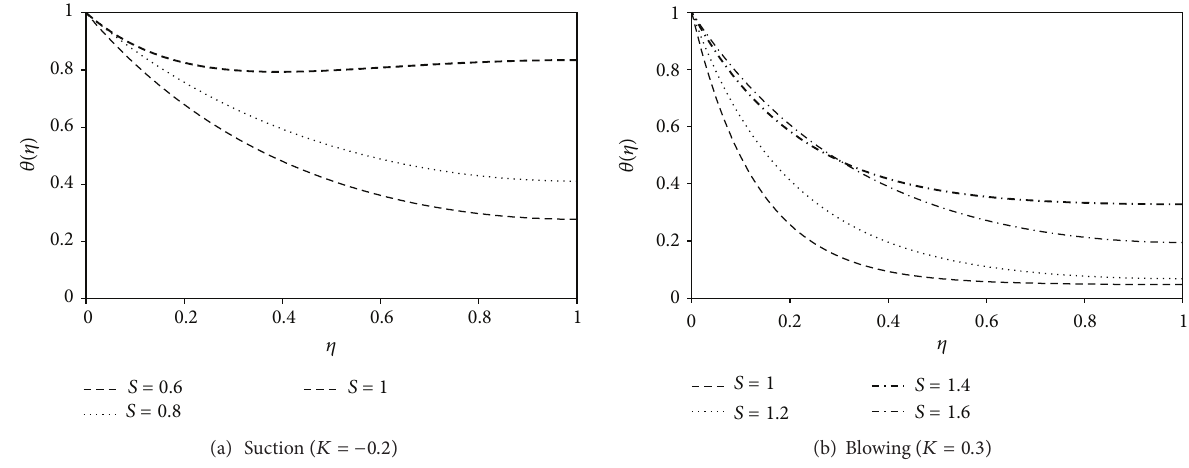
Figure 7: The effect of unsteadiness parameter 𝑆 on the temperature distributions 𝜃(𝜂) using 10th-order HAM approximation when Pr = 1